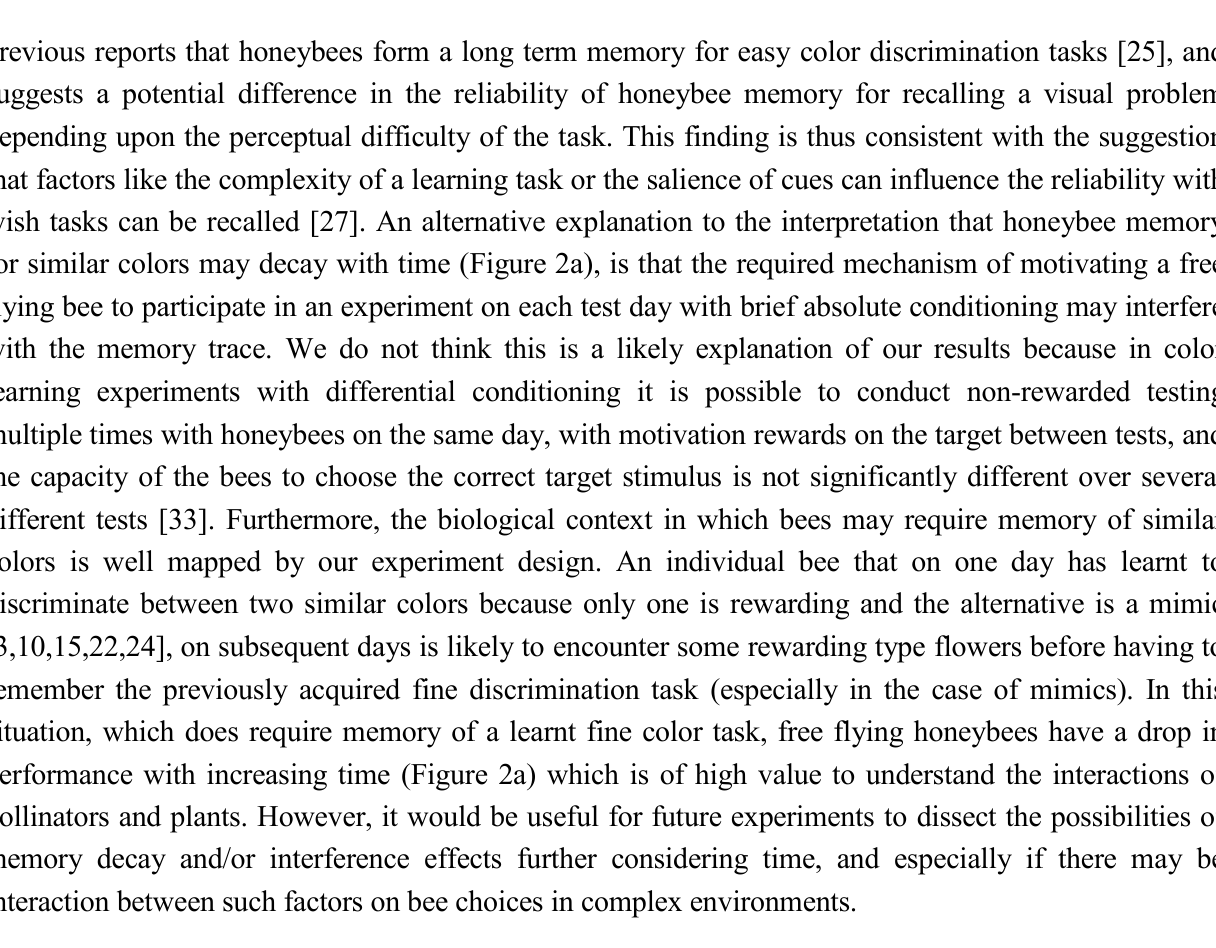
Table 1. Parameters and 95% confidence intervals of the logistic regression models fitted to each one of the n = 12 bees used during the study. The model describes changes in the percentage of correct choices as a function of time for two different colour discrimination tasks, and statistically tests the significance of the slope. † Confidence intervals constructed based on a likelihood-based profile. § p -values calculated from differences in deviance values. ** Significant slopes at α =